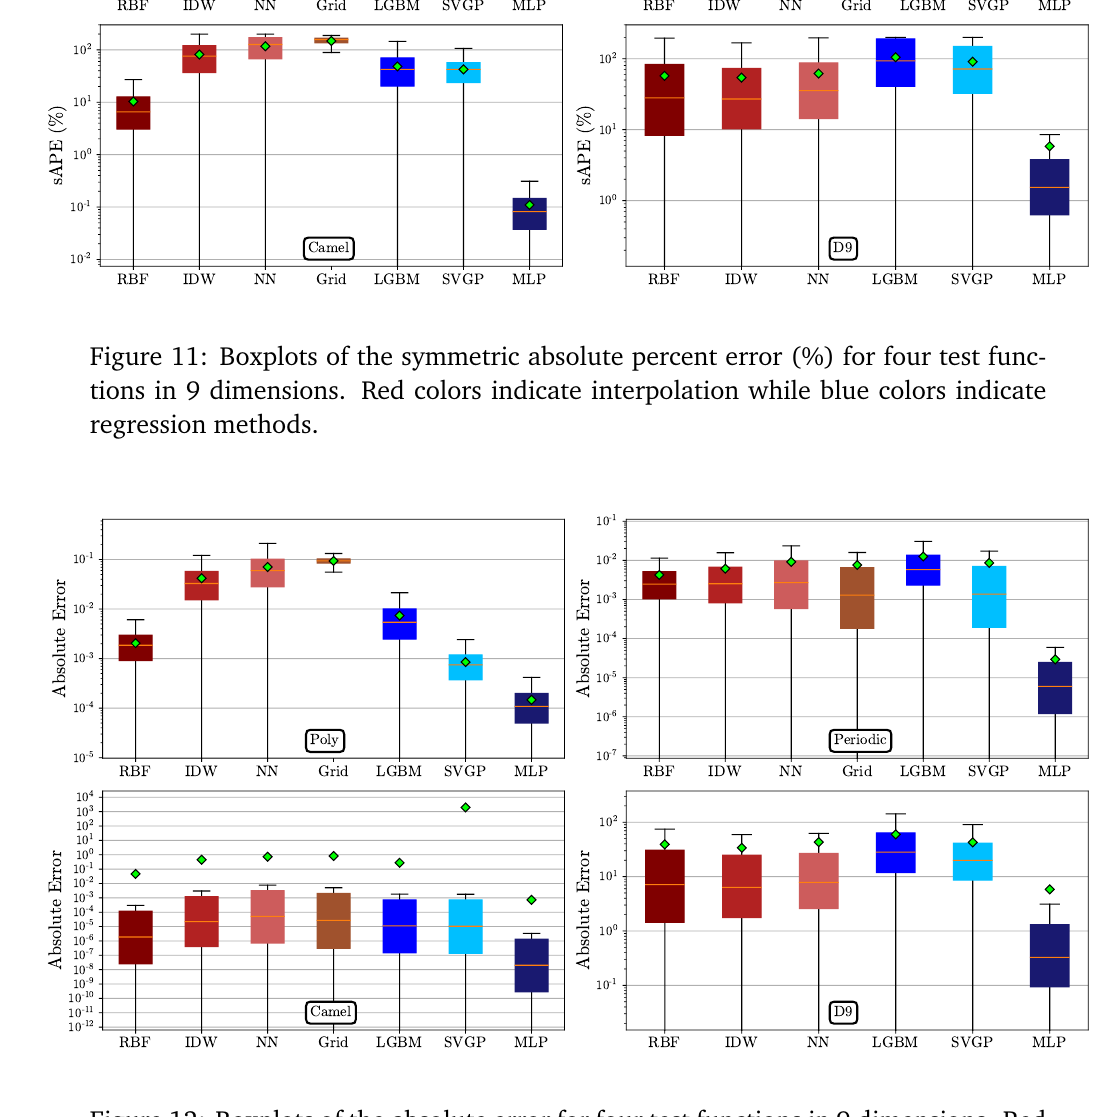
Figure 12: Boxplots of the absolute error for four test functions in 9 dimensions. Red colors indicate interpolation while blue colors indicate regression